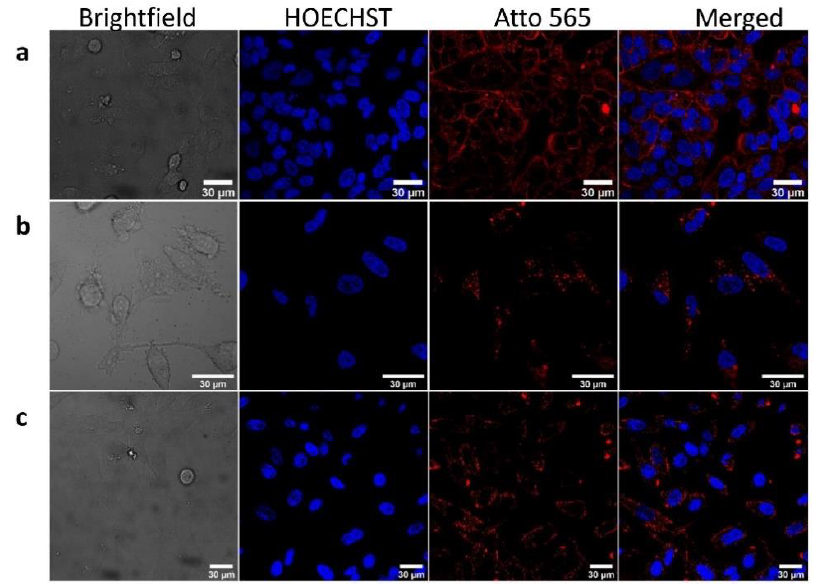
Figure 7. Confocal microscopy images of HeLa cells after treatment with: ( a ) BSA-r 8 -A565, ( b ) AuNR-BSA-r 8 -A565, ( c ) AuNPr-BSA-r 8 -A565 incubated for 24 h. Scale 30 µm. [BSA-r 8 ] = 5 µM, [AuNR-BSA-A565-r 8 and AuNPr-A565-BSA-r 8 ] = 1 nM. Channels: bright blue (HOECHST), red (Atto-565), blue and red (merged).